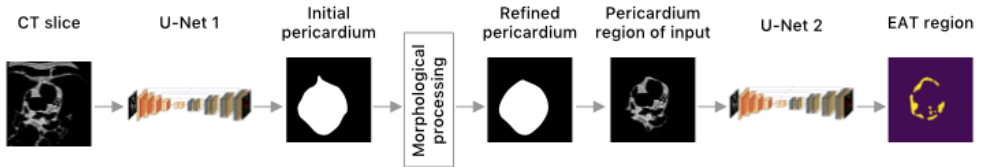
Figure 11. A summary of the method presented in Zhang et al. [36]. The CT slice is fed into a U-Net-based CNN which segments the pericardium mask. The mask is refined using morphological processing and used to mask the input for a second U-Net based CNN which segments the EAT